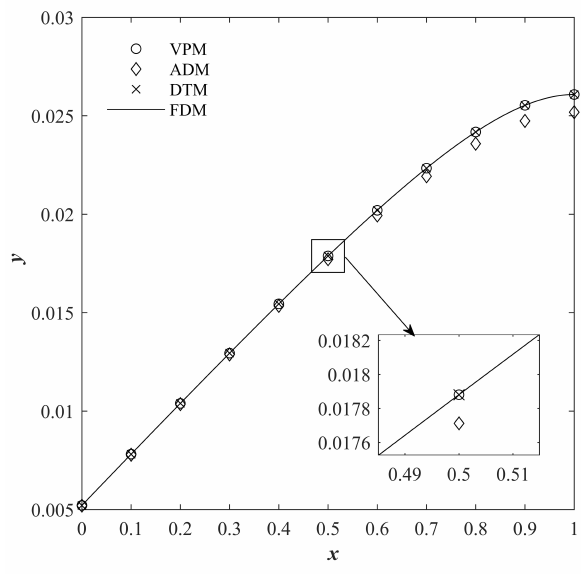
Fig. 4: Comparison of the solutions to equation (33) using all meth- ods